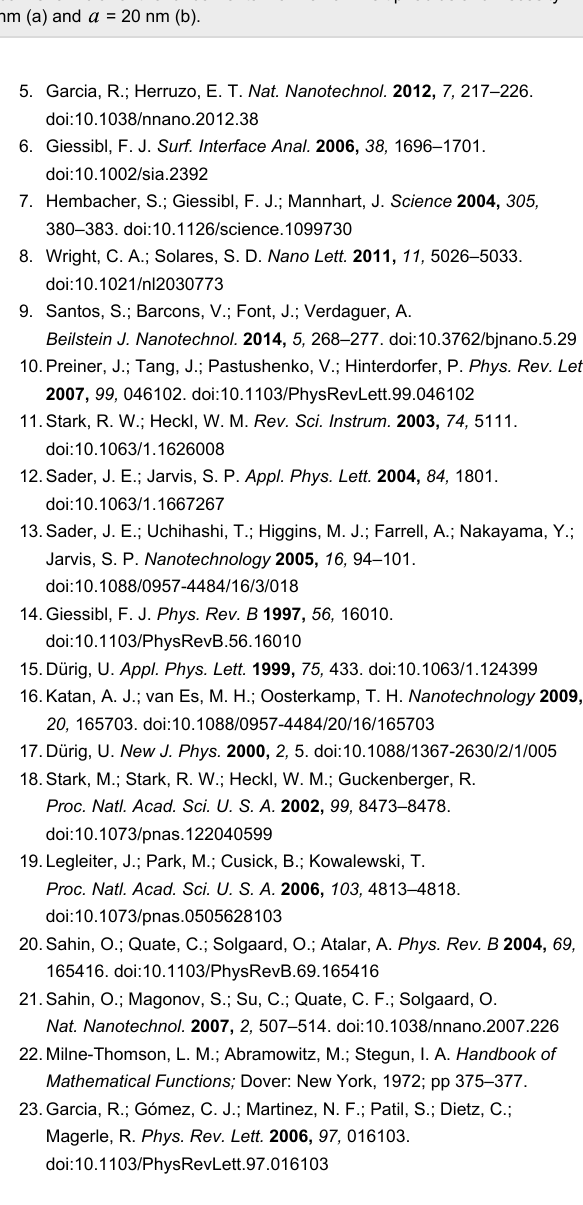
Figure 2: Generalized damping coefficient of a viscous interaction (solid red line) and its reconstructions. Blue circles depict reconstruction using the second harmonic. Green diamonds depict reconstruction using the Sader–Jarvis formula for the fundamental harmonic. The tip radius and viscosity are R = 10 nm and η = √ 10 Pa·s. The amplitudes of oscillation are = 10 nm (a) and = 20 nm (b).